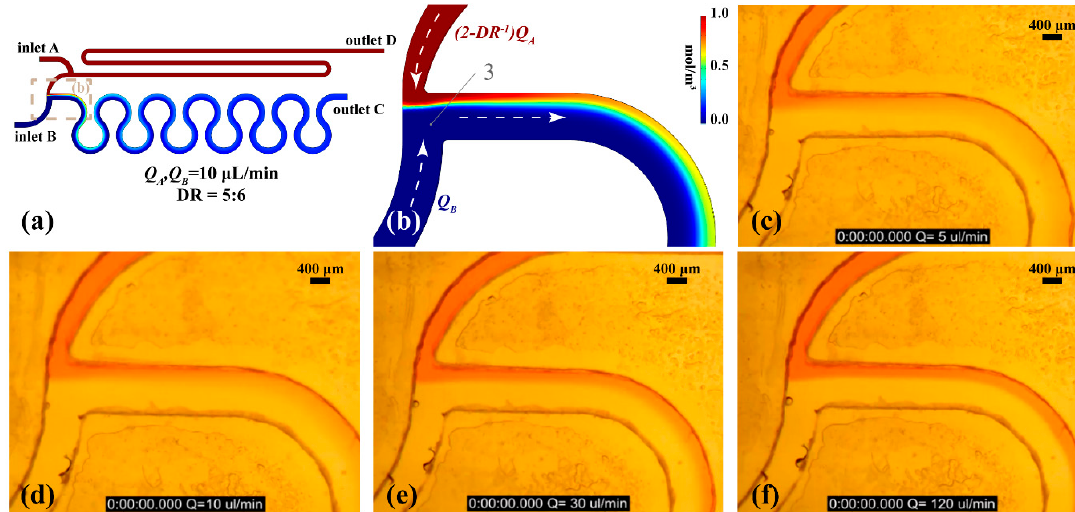
Figure 6. Serial diluter unit cell prototyped on PMMA. ( a ) design top view. Simulation results of the concentration field ( b ) detail of the concentration field at the merging point 3. Sample inlet and buffer inlet flow rates equal to ( c ) 5 μ L/min ( d ) 10 μ L/min ( e ) 30 μ L/min ( f ) 120 μ L/min.